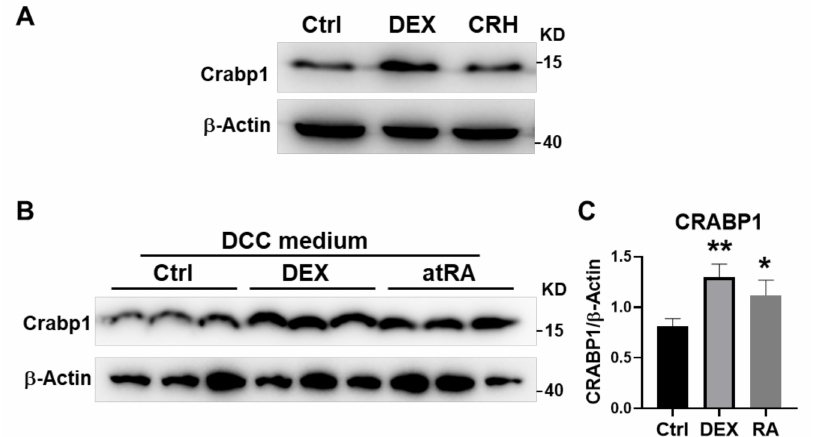
Figure 5. Crabp1 protein levels in AtT20 cells. ( A ) Crabp1 level in AtT20 cells after 24 h DEX or CRH treatment. ( B ) Crabp1 level in AtT20 cells grown in DCC FBS-supplemented medium after 24 h. RA or DEX treatment. Western blot quantification shown in ( C ). β -actin was used as a loading control. Results are presented as means ± SEM, * p ≤ 0.05, ** p ≤ 0.01, compared with the Ctrl